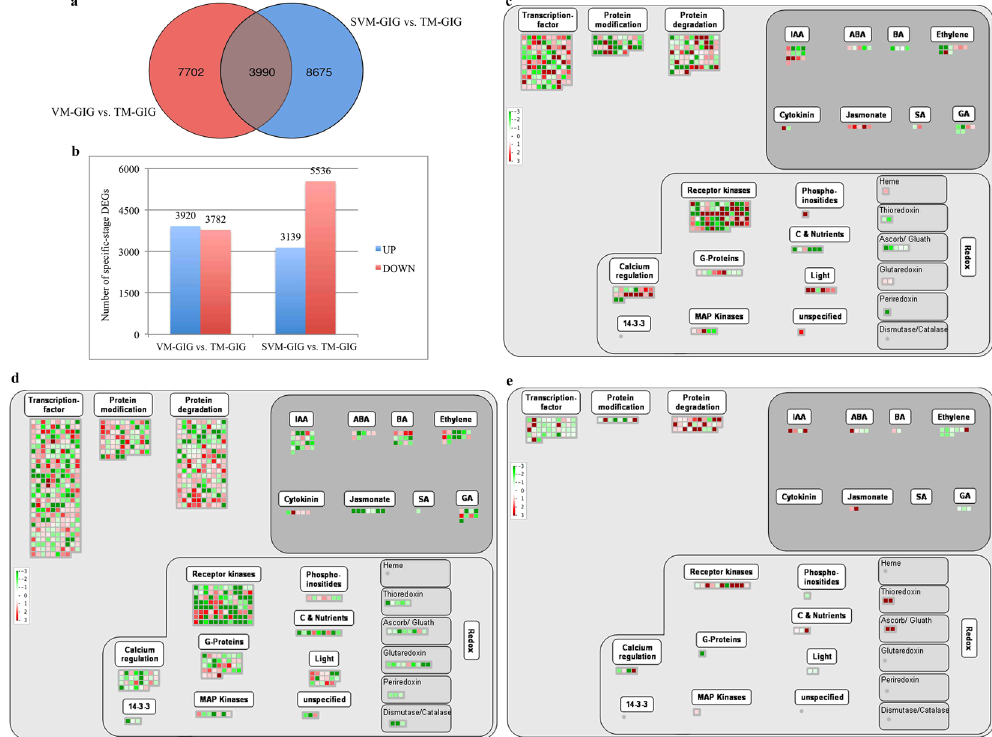
Figure 2. Number of DEGs and MapMan regulation overview maps in each comparison. ( a ) Number of conserved and stage-specific expression DEGs in pairwise comparisons of GIG. ( b ) Stage-specific comparison of DEGs in GIG. ( c ) MapMan regulation overview maps showing the transcript levels of stage-specific DEGs in the VM-GIG vs. TM-GIG comparison. ( d ) MapMan regulation overview maps showing the transcript levels of stage-specific DEGs in the SVM-GIG vs. TM-GIG comparison. ( e ) MapMan regulation overview maps showing the transcript levels of DEGs in the VM-OB vs. TM-OB comparison. The color indicates log 2 value of fold changes, green color represents down-regulated transcripts, and red color represents up-regulated